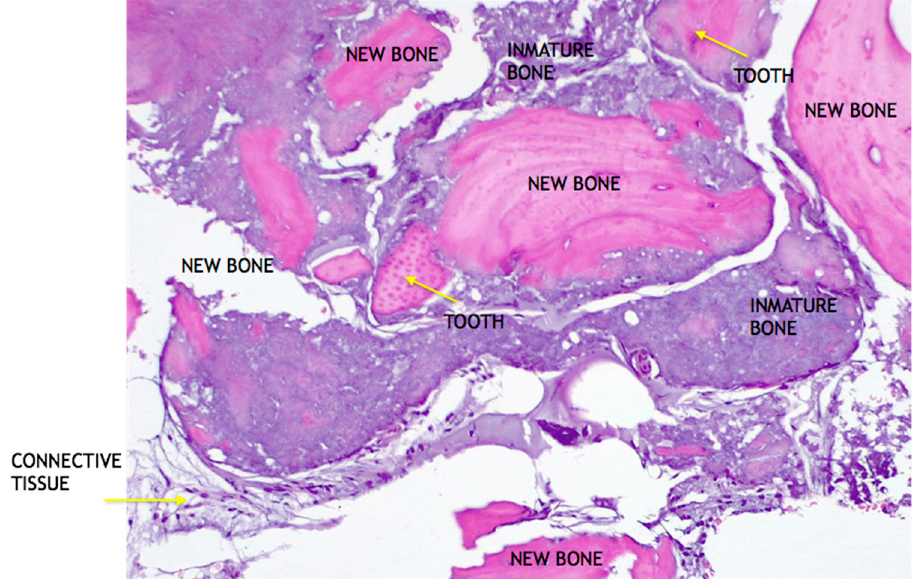
Figure 11. Twenty ‐ four months of evaluation with highly lamellar bone around dentin particles. Figure 11. Twenty-four months of evaluation with highly lamellar bone around dentin particles.